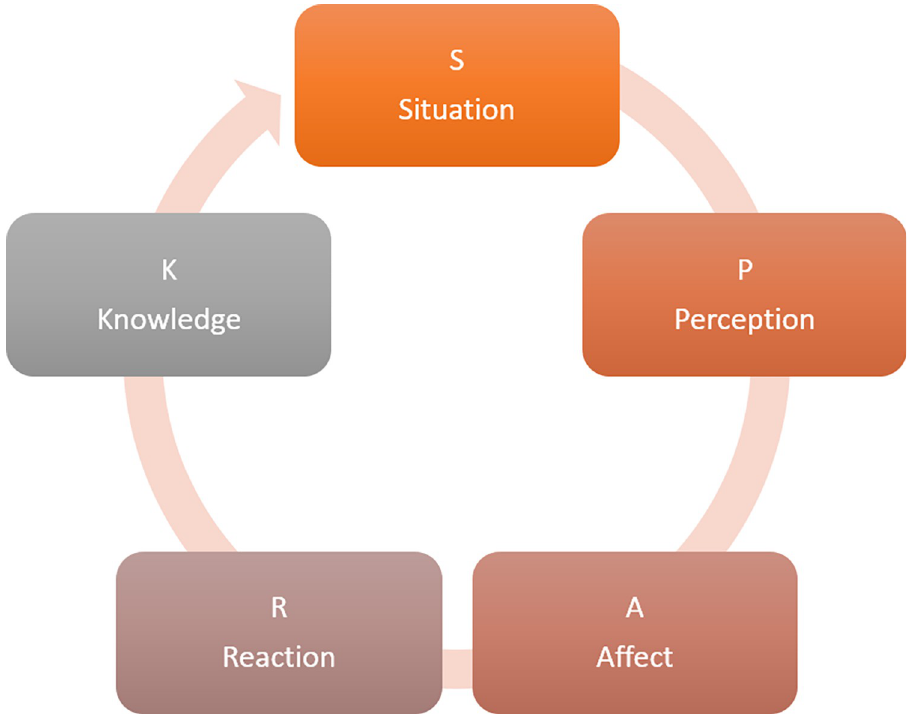
Fig 1. The SPARK Resilience